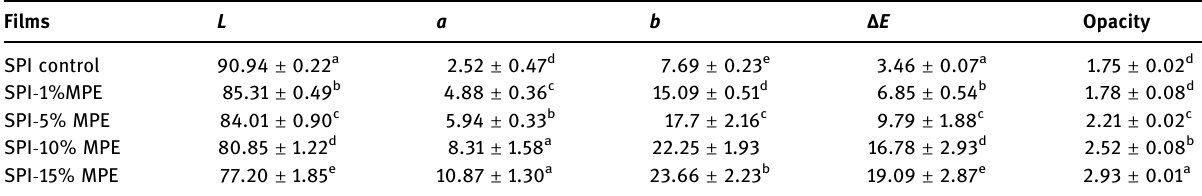
Table 6: Color and opacity of SPI fi lms as a ff ected by MPE incorporation